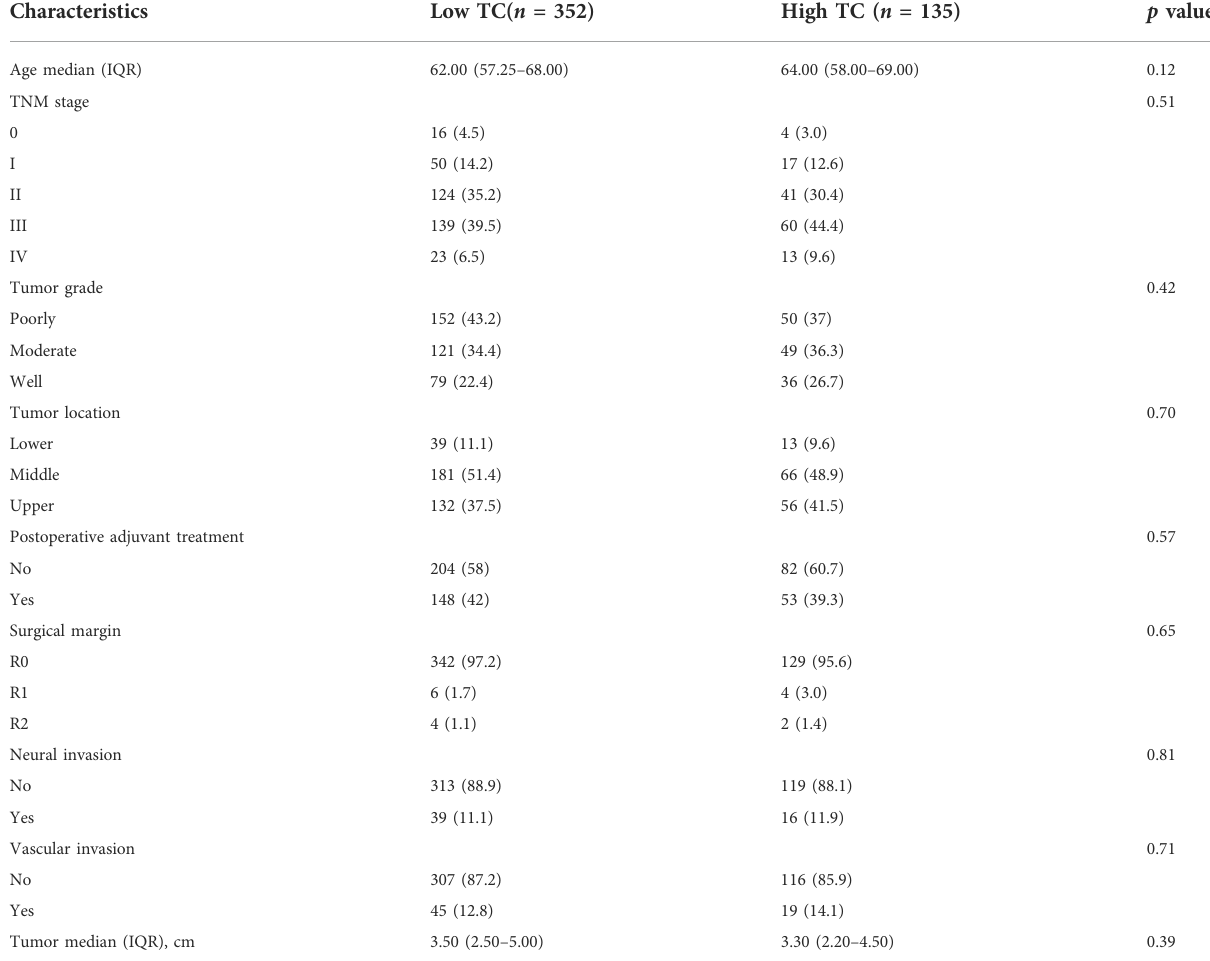
TABLE 6 Serum total cholesterol and characteristics of the female patients with ESCC.